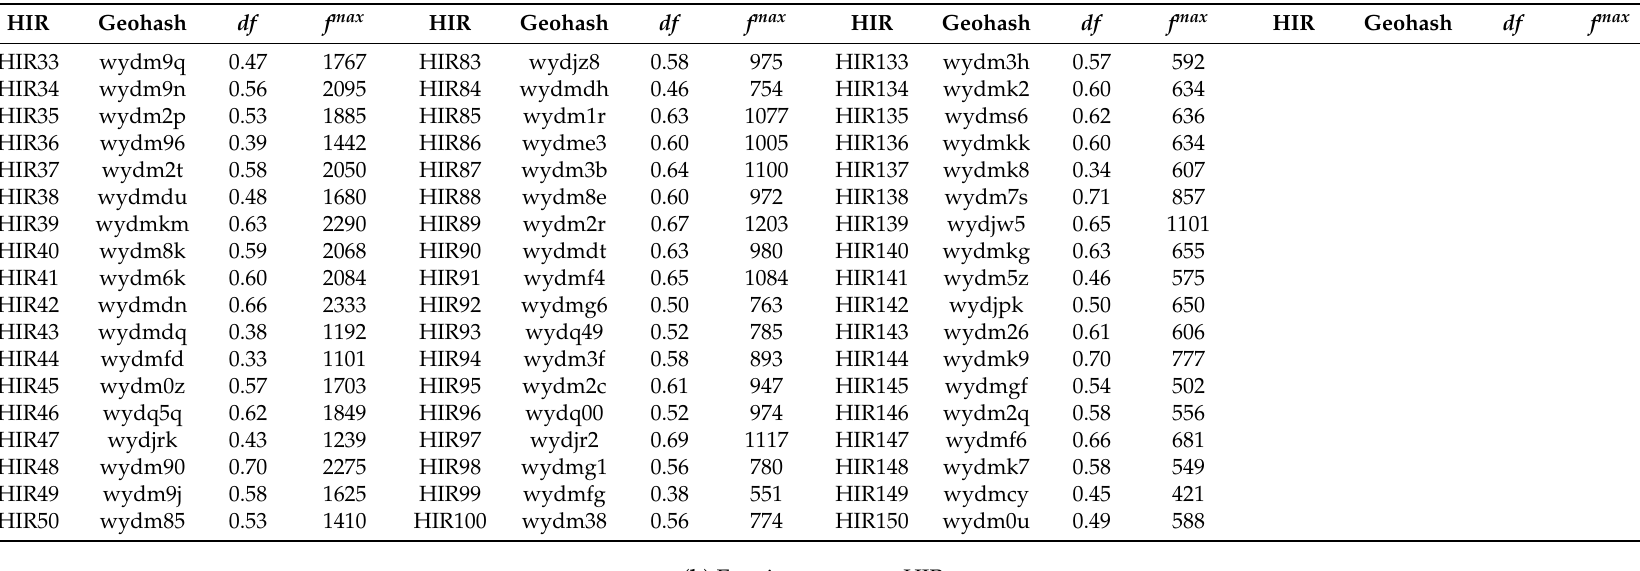
( a ) Morning commute